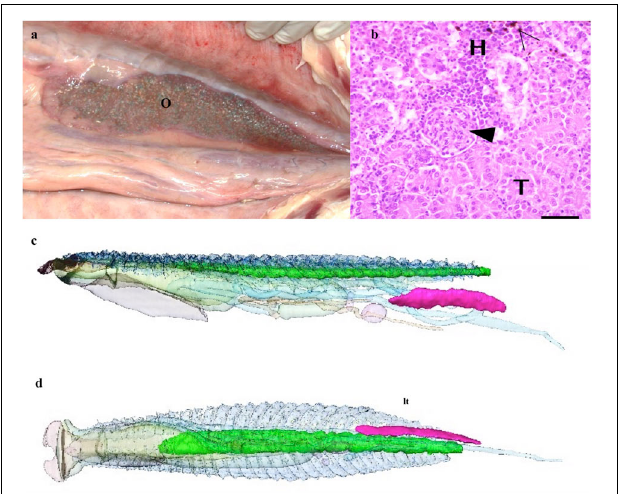
FIGURE 5 | Ovary and kidneys. (a) Gross anatomy of ovary (O) in the peritoneal cavity. (b) Kidney- light micrograph showing hematopoietic tissue (H), renal tubules (T), capillary tuft (arrowhead) and melanomacrophages (empty arrowhead). (c) 3D reconstruction from CT data of kidneys (green) and ovary (magenta) as seen from left side and (d) from below looking up. Other organs as described above but semitransparent for